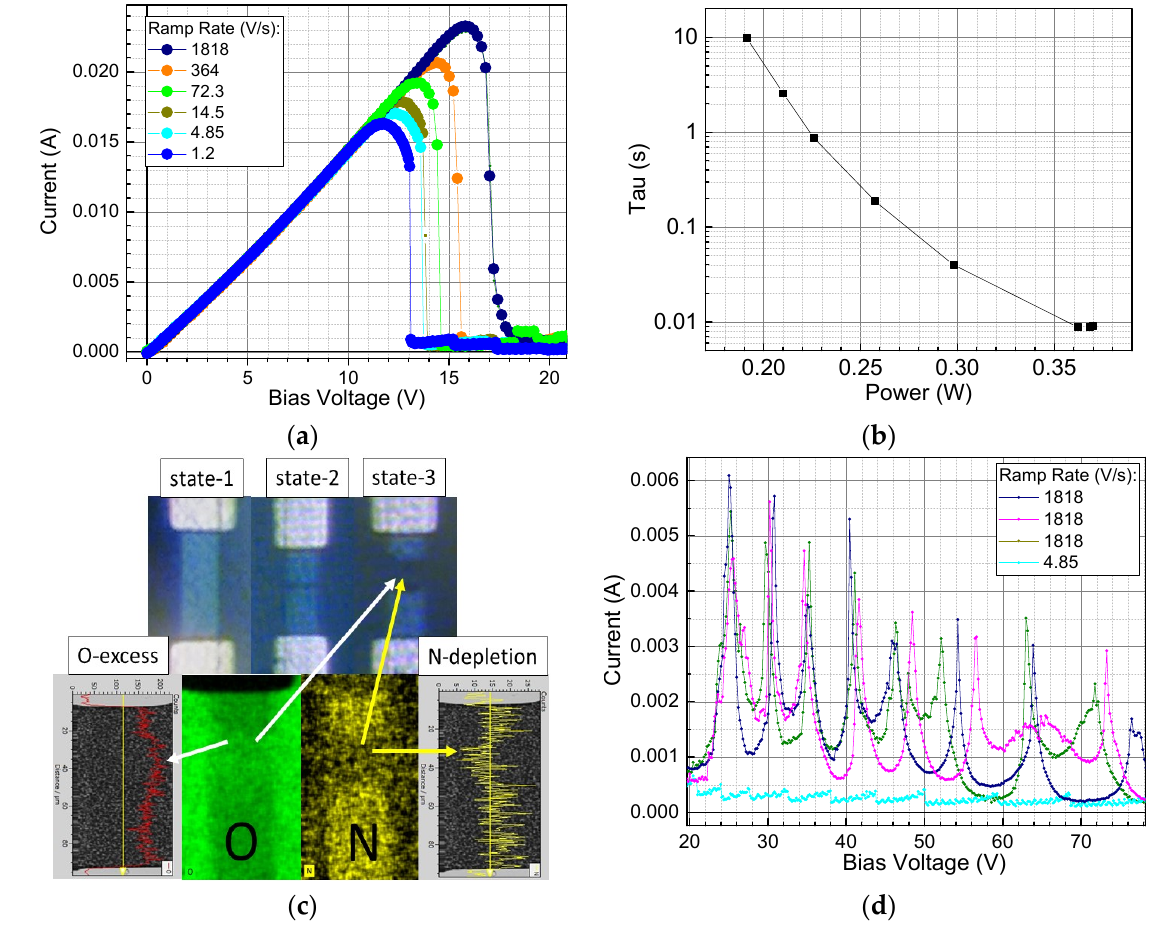
Figure 6. High voltage stress test: ( a ) I–V curves measured for several resistors destroyed at different voltage ramps, lower ramps fuse resistor at low voltage; ( b ) fusible resistor life-time versus maximum allowed power in the low-resistivity state; ( c ) EDX 2D map showing relative oxygen excess and nitrogen depletion in the voltage stress damaged region of the resistor body; and ( d ) oscillatory current spikes observed at high voltage ramps at higher voltages. The spikes gradually turn into a saw-like pattern as we decreased the voltage ramp from 1818 V/s down to 4.85 V/s.